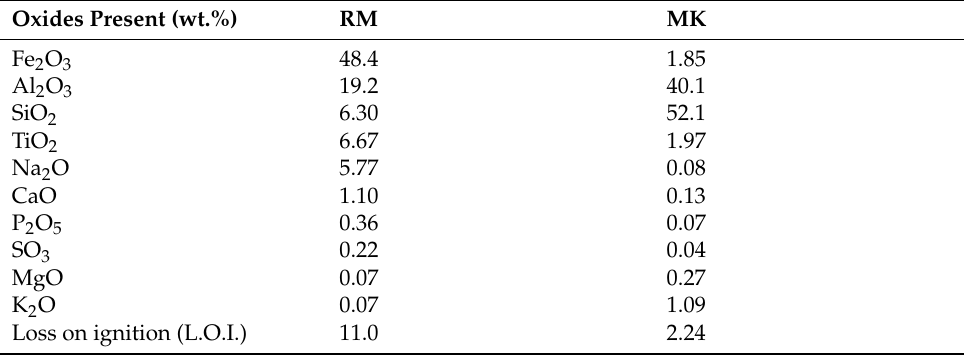
Table 2. Oxide composition of RM and MK. Oxides Present